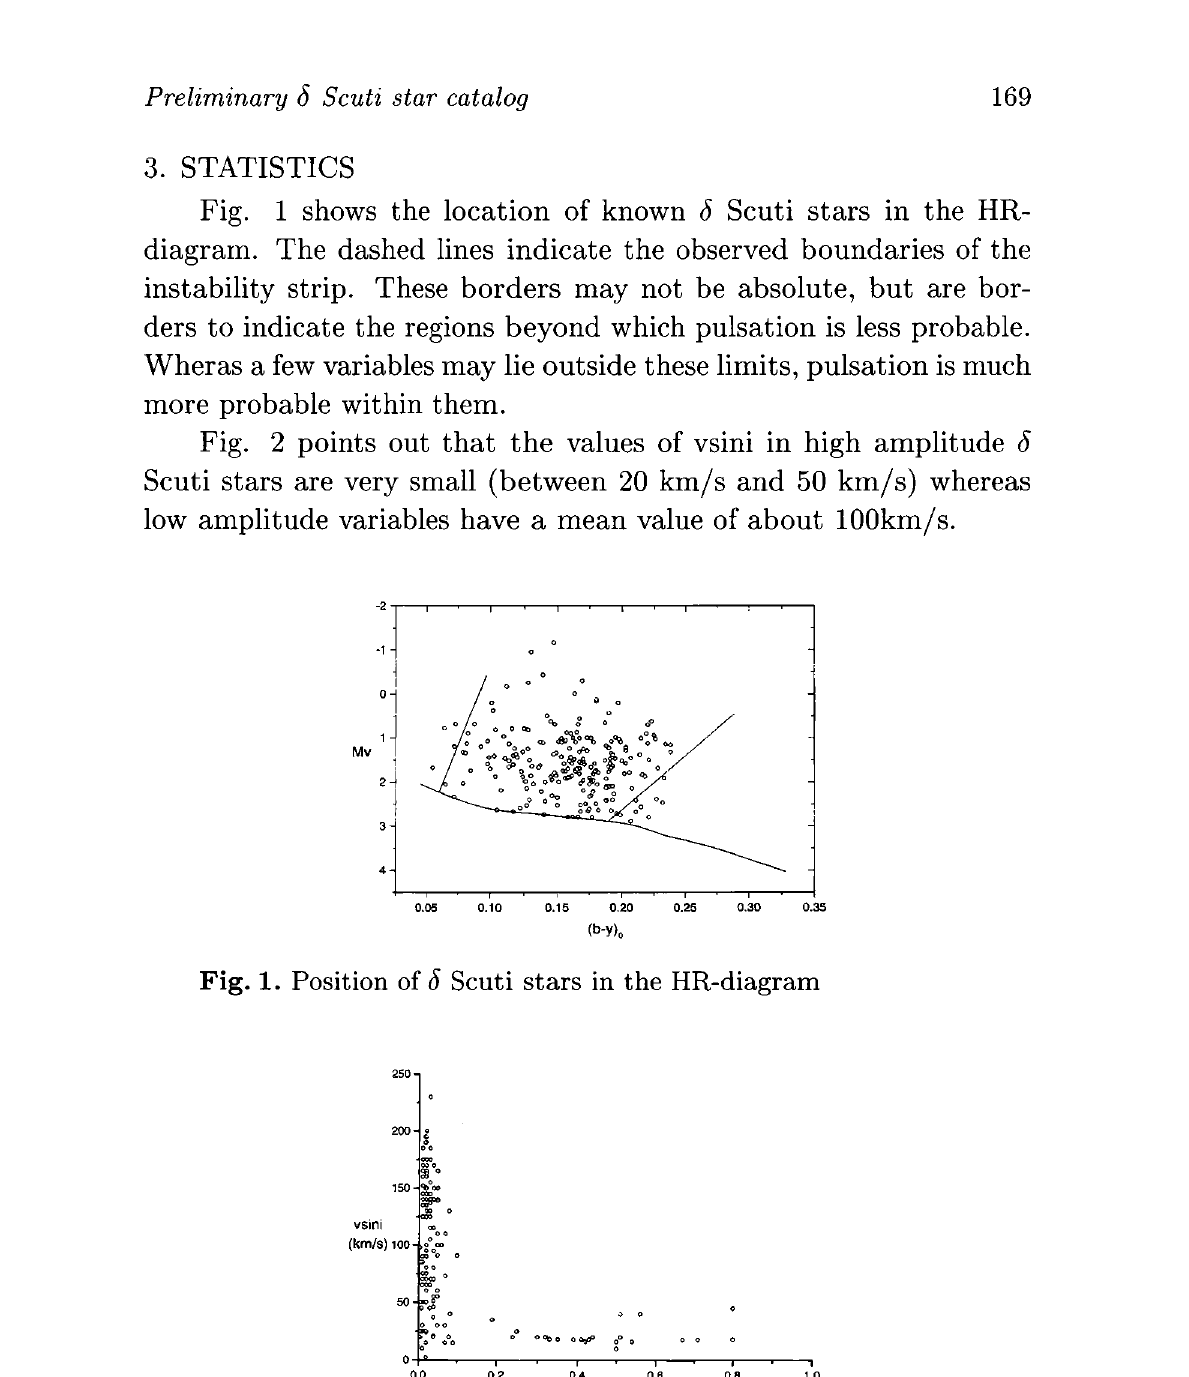
Fig. 2. Full average of the visual amplitude versus rotational